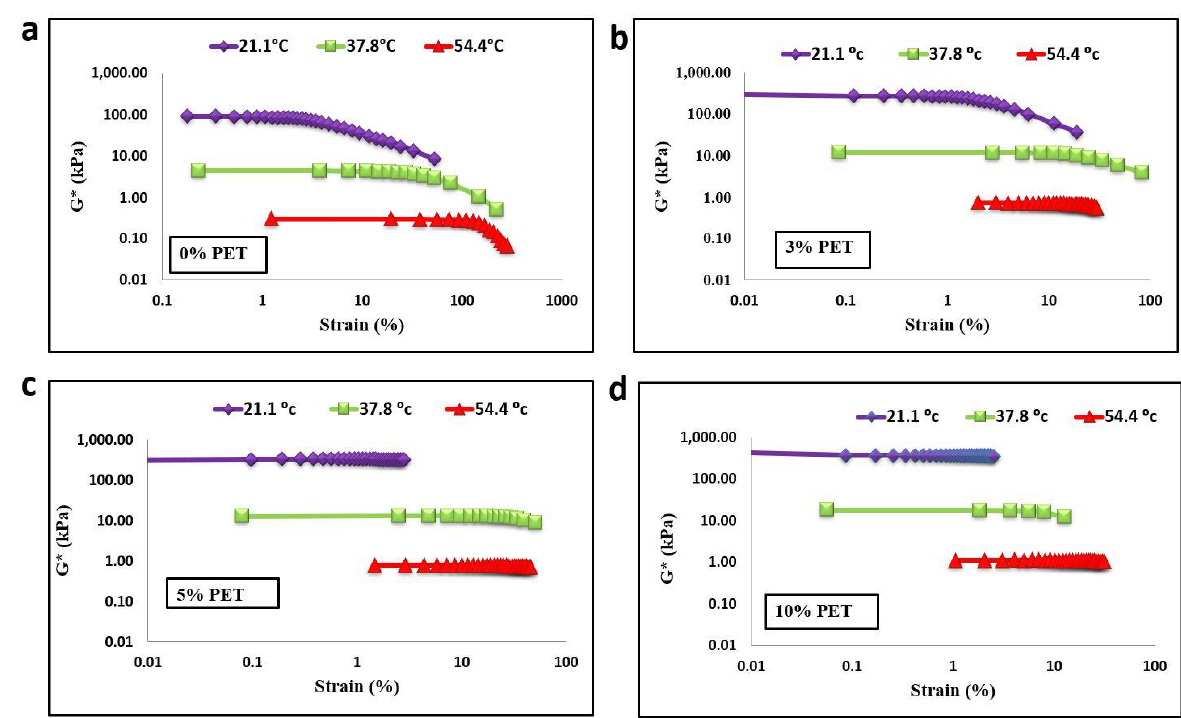
Figure 6. Linear viscoelastic range of RTFO-aged binder with PET content of ( a ) 0%, ( b ) 3%, ( c ) 5%, and ( d ) 10%.